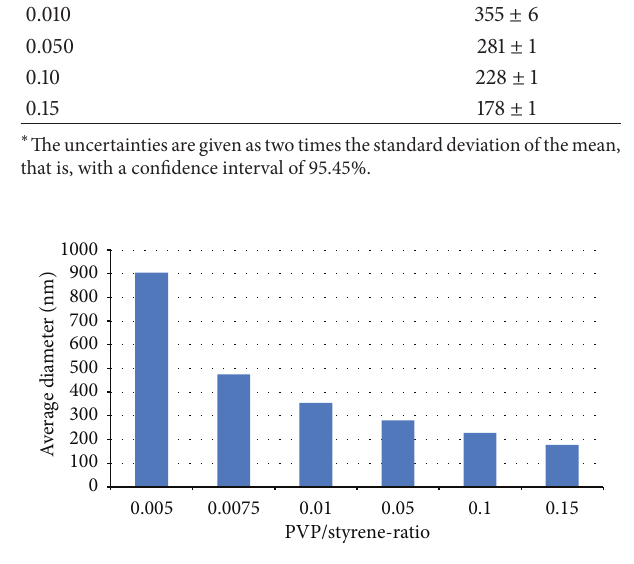
Figure 3: Average diameter of the polystyrene templates as a func- tion of